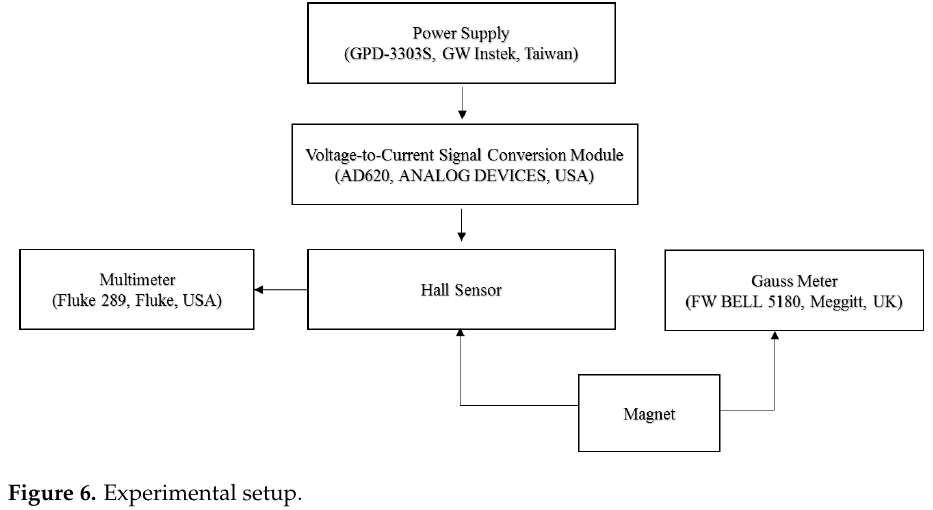
Figure 6. Experimental setup.